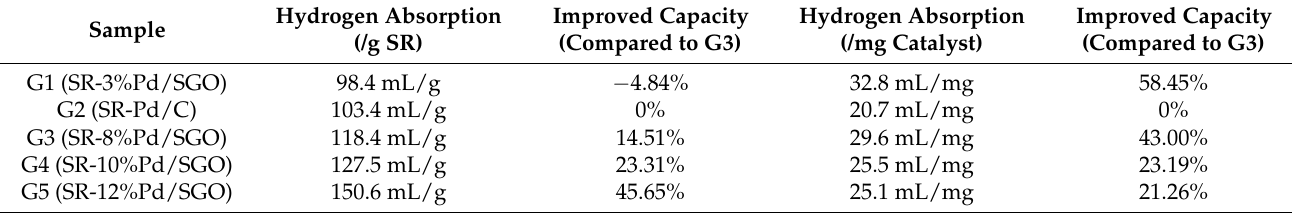
Figure 9. TEM images of ( a , b ) GO, ( c , d ) SGO, and ( e , f ) Pd/SGO. Table 3. Hydrogen absorption results of G1, G2, and G3